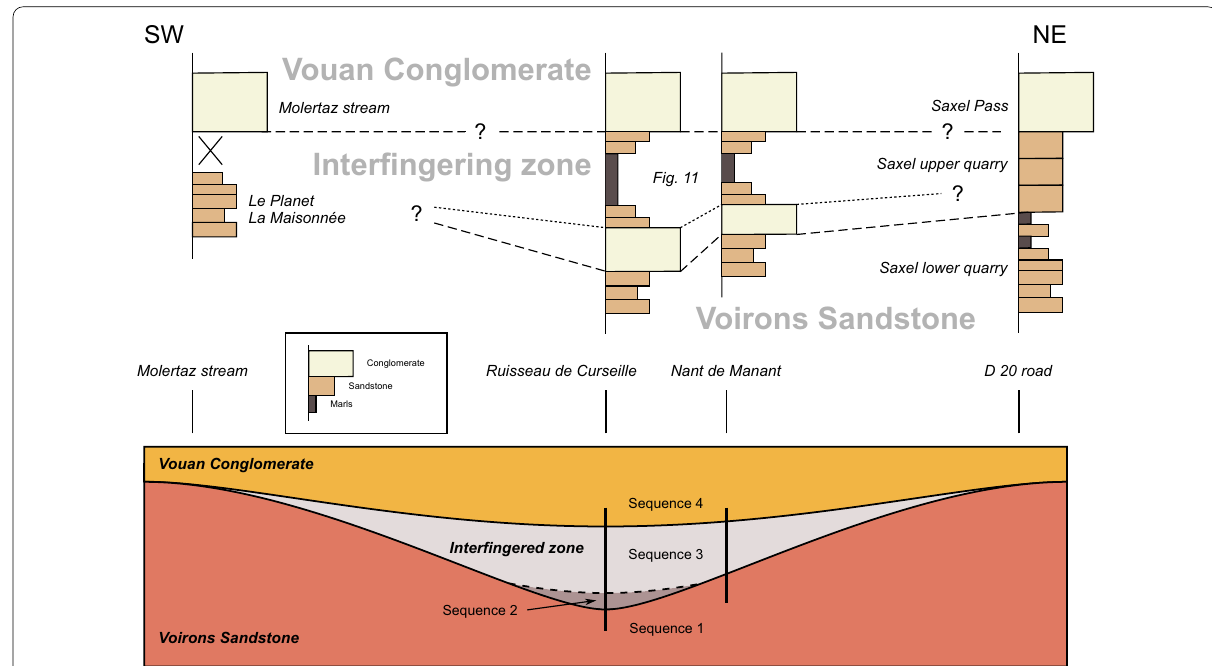
Fig. 12 Synthetic cross‑sections of the contact between the Voirons Sandstone and the Vouan Conglomerate at the Voirons showing the lateral variations of the stratal pattern and the restricted channel at the inception of the deposition of the Vouan Conglomerate. Beds thicknesses are not to